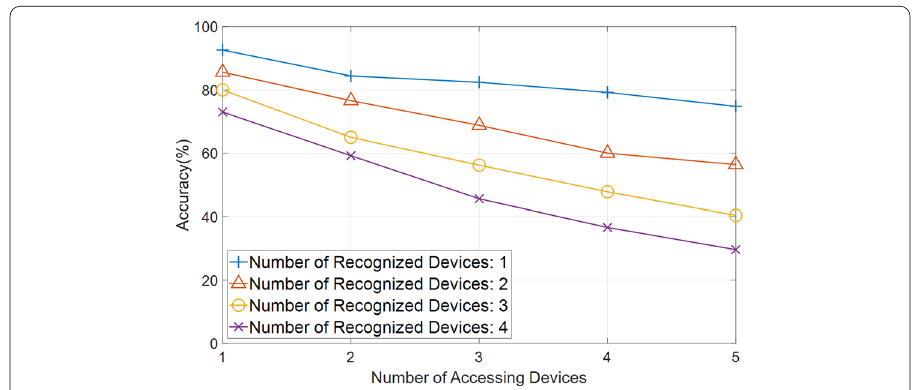
Fig. 24 Accuracy of the scheme with multiple devices. We take 500 experiments for mutiple recognized devices and accessing devices. The experiments are taken under the conditions of training for 5 times and